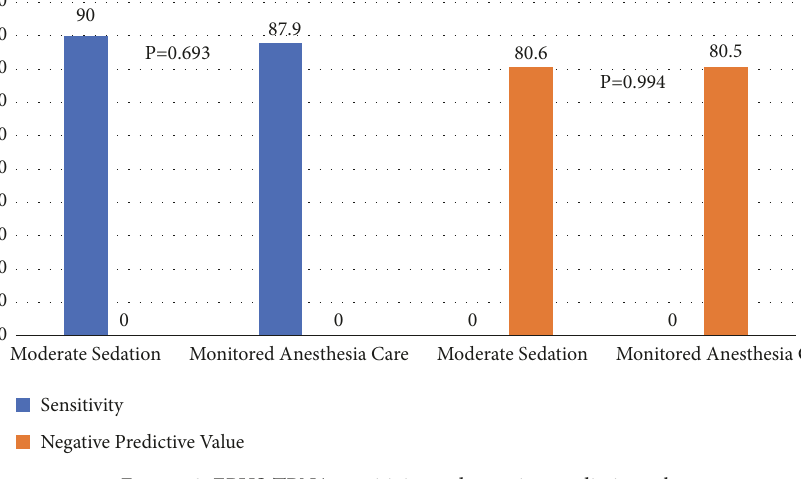
Figure 2: EBUS-TBNA sensitivity and negative predictive value.